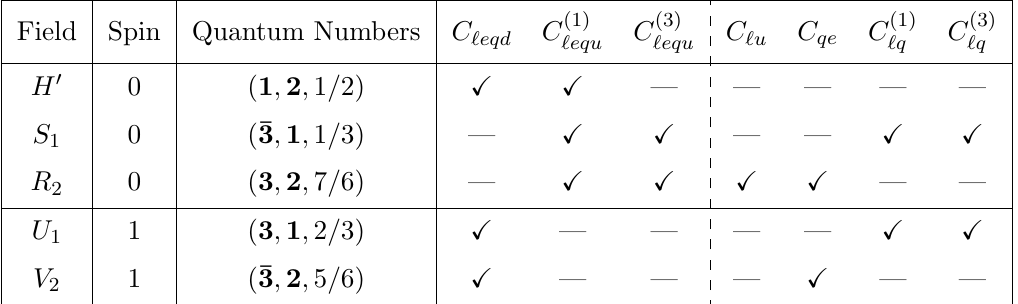
(1) , and ‘equ O ‘eqd O